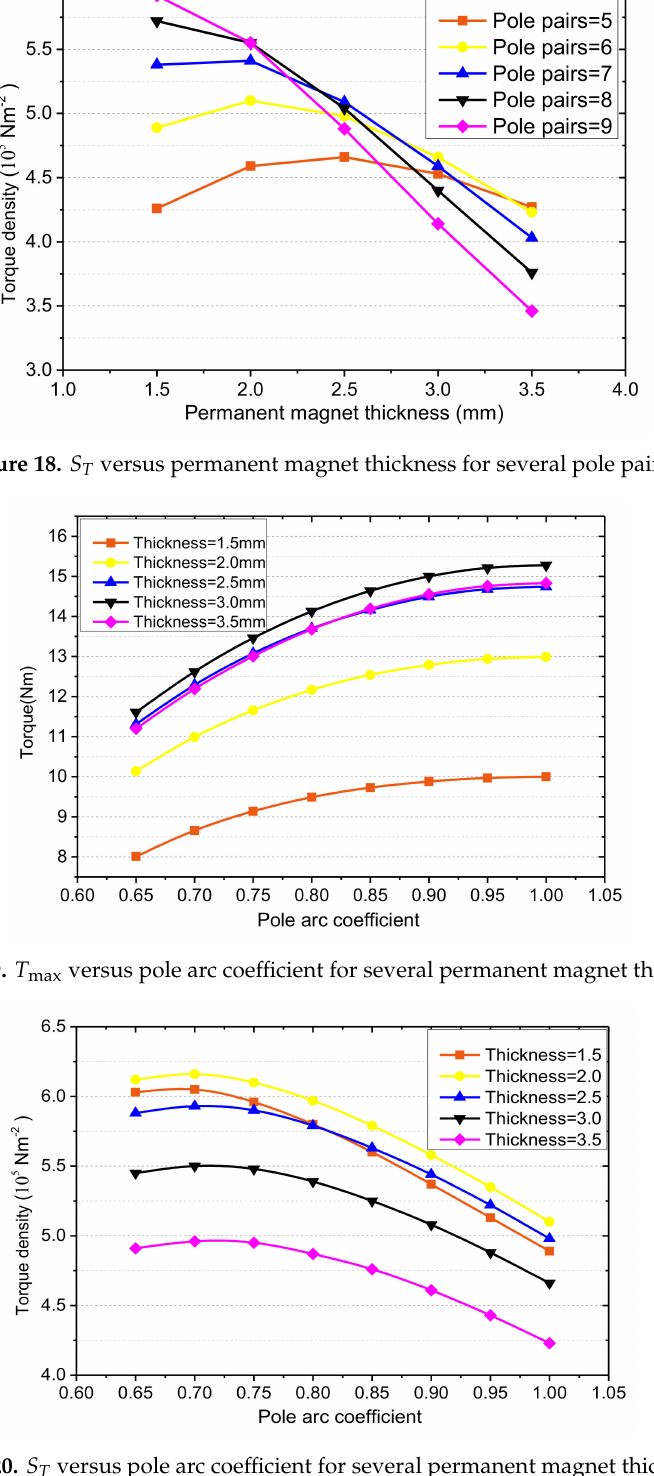
Figure 20. S T versus pole arc coe ffi cient for several permanent magnet